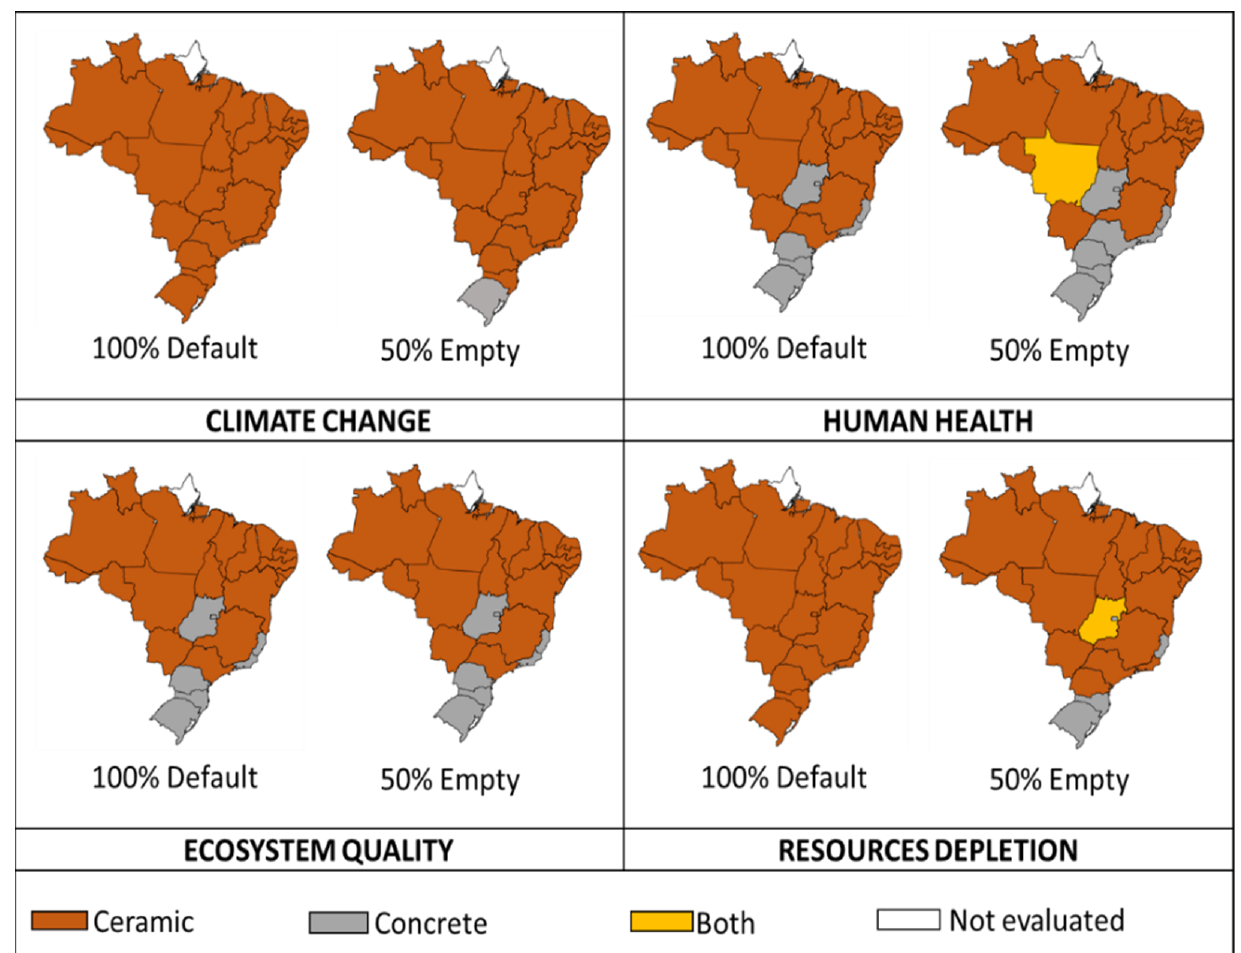
Figure 7. Environmental impact map—comparison between concrete and ceramic blocks. Orange = ceramic blocks are the most advantageous; gray = concrete blocks are the most advantageous; yellow = less than 5% difference between the total Resource Depletion impacts from ceramic and concrete blocks; 100% Default—represents that the truck is loaded with 100% of its capacity and returns full; 50% Empty—represents that the truck is loaded with 50% of its capacity and returns